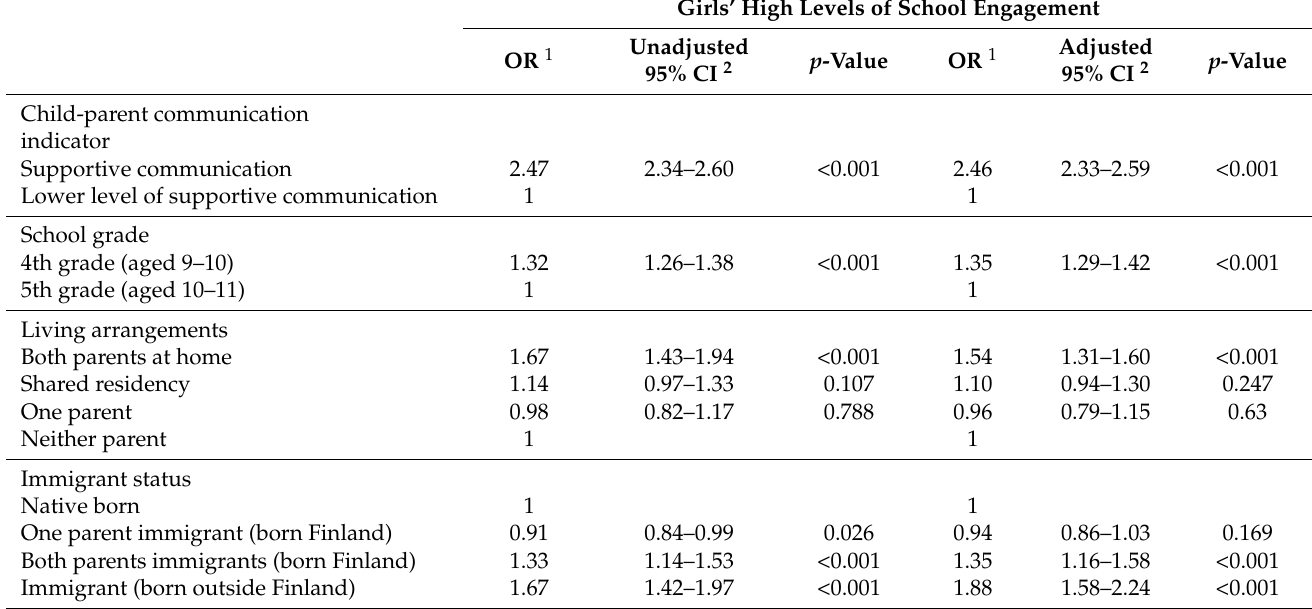
Table 6. ORs and 95% CIs for background factors and child-parent relationships of girls aged 9–11 years in relation to high levels of school engagement